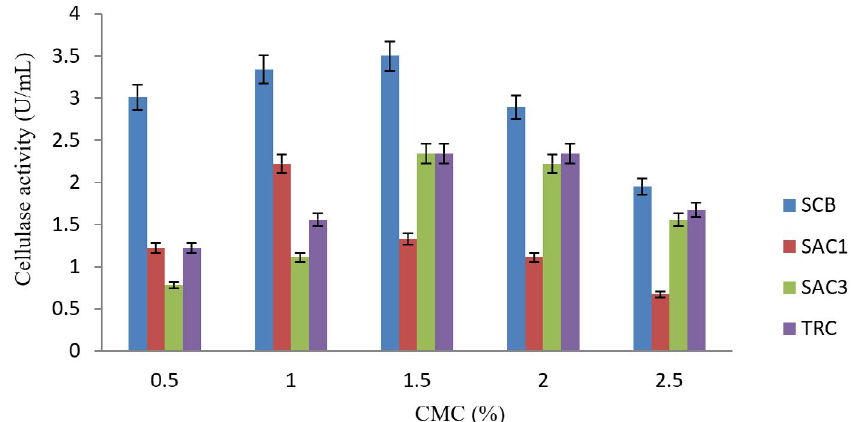
Fig. 1. Consequence of diverse concentrations of carboxylmethyl cellulose on the production of cellulanase by fungi